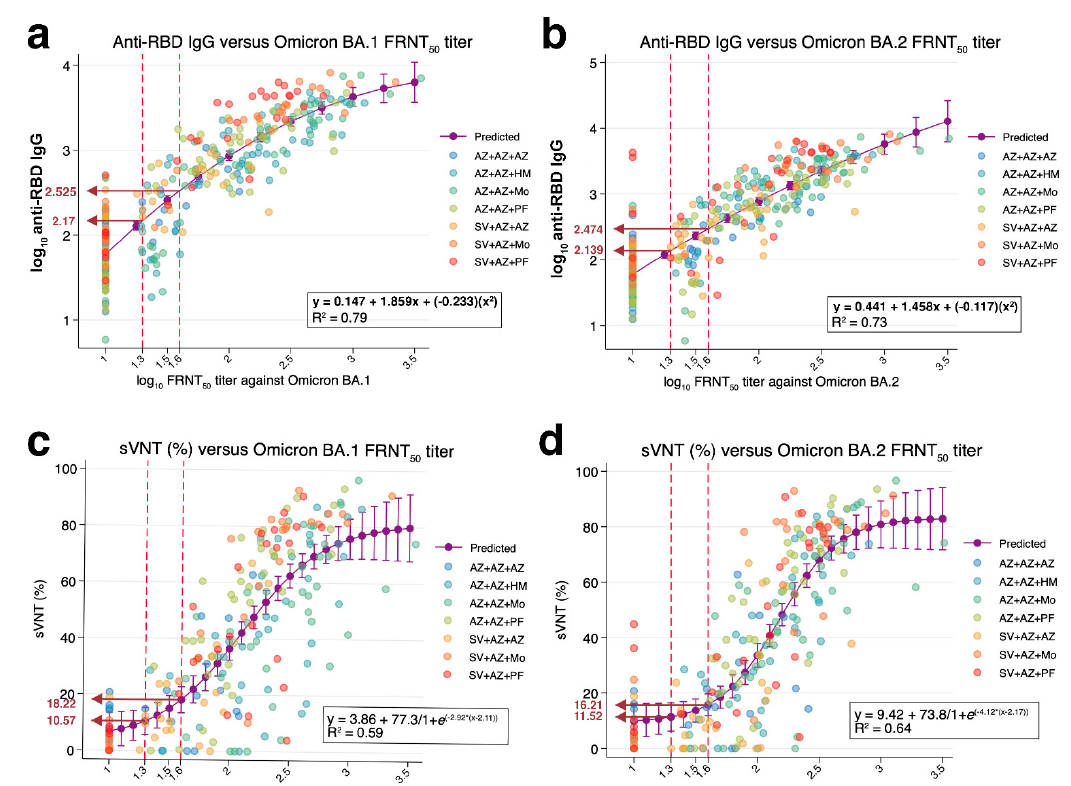
Figure 1. Prediction of the level of anti-RBD IgG tested against the ancestral strain and the percentage of blocking between RBD and ACE-2 interaction against omicron based on the FRNT50 assay against SARS-CoV-2 omicron BA.1 and BA.2 variants using non-linear regression analysis. Sera samples from individuals with booster vaccination were tested with anti-RBD IgG against wild-type, sVNT against omicron, and FRNT50 against omicron BA.1 and BA.2. Predicted anti-RBD IgG level ( n = 310) was based on the FRNT50 titer against BA.1 (Panel ( a )) and BA.2 (Panel ( b )). Predicted sVNT level ( n = 218) was based on the FRNT50 against BA.1 (Panel ( c )) and BA.2 (Panel ( d )). The y axis represents log10 scale of anti-RBD IgG (BAU/mL). The x axis represents the log10 of FRNT50 titers. Dotted lines indicate 1.3 (the cut-off value of FRNT50 titer = 20) and 1.6 (the cut-off value of FRNT50 titer = 40). The arrows indicate the predicted level of anti-RBD IgG and percentage of inhi- bition from sVNT. Colored circles indicate the vaccine regimens for primary vaccine series+ booster vaccine. The r-square was calculated according to the non-linear equation using STATA v.17.0 soft- ware. SV = CoronaVac (Sinovac, Beijing, China), AZ = AZD1222 (AstraZeneca, Oxford, UK), PF = BNT162b2 (Pfizer-BioNTech, Mainz, Germany), Mo = full dose mRNA-1273 (100 µg) (Moderna, Massachusetts, MA, USA), HM = half dose mRNA-1273 (50 µg). Table 1. Anti-RBD IgG against wild type, sVNT against omicron, FRNT50 titers against BA.1 and BA.2 among the booster vaccination groups.